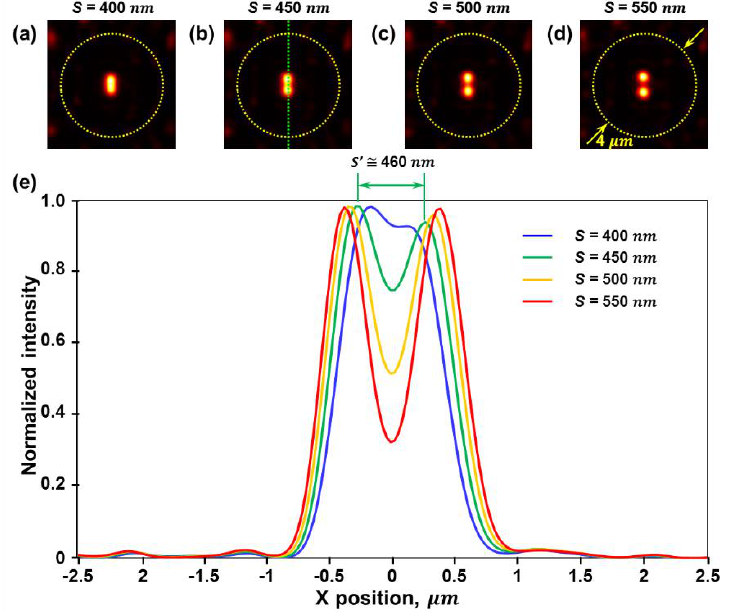
Figure 3. Imaging of two separated incoherent point light sources by a 5-fold symmetry quasi-periodic nanohole array lens. Plates ( a ) to ( d ) show the calculated patterns of imaging two incoherent light sources with a separation of 400 nm, 450 nm, 500 nm and 550 nm, respectively. The two point light sources of λ = 660 nm are placed at Z obj = 11.4 μm away from a 5-fold symmetry quasi-periodic nanohole array lens, while the imaged patterns are generated at Z img = 11 μm. The size of the images is 5 × 5 μm 2 and the yellow dashed circles indicate the effective imaging area of the quasi-periodic nanohole array lens. Plate ( e ) shows the cross-section profiles of the two imaged spots in the imaged patterns. Note that two coherent point light sources are resolved when they are separated by S = 450 nm, while the distance between the two imaged spots is around S ′ = 460 nm, giving an effective N.A. of